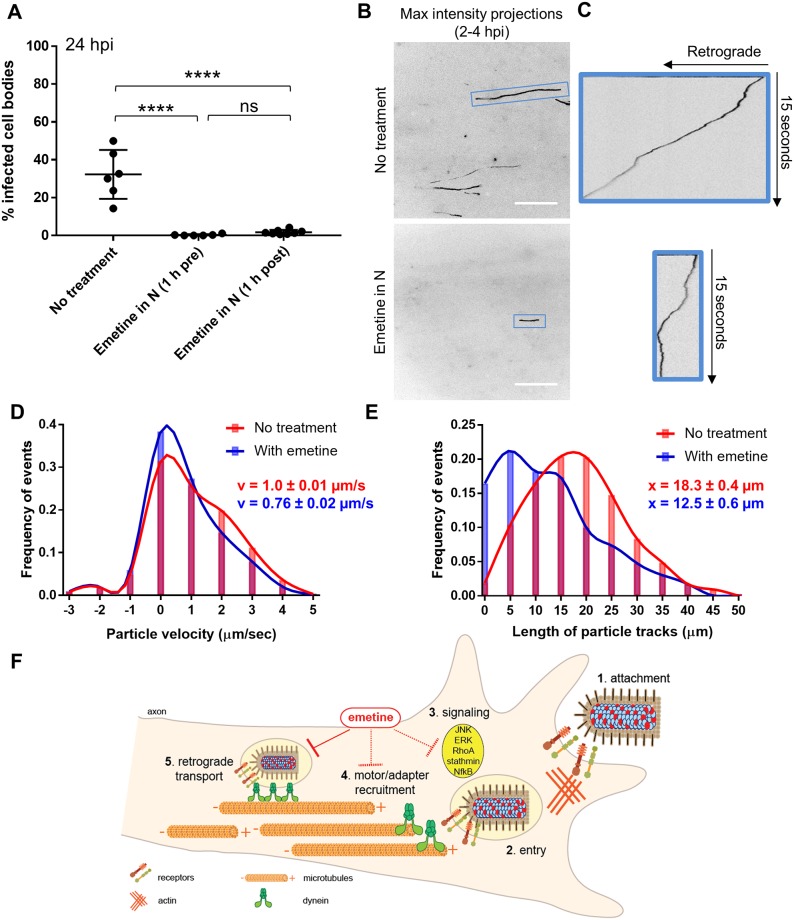
Emetine acts after RABV entry to reduce the velocity and transport distance of virus particles moving retrograde in axons.(A) Quantification of % infected cell bodies at 24 hpi (+/-) 100 μM emetine added to N either 1 h pre or 1 h post infection. Black dots represent individual tri-chambers (from two independent replicates). Horizontal lines and errors bars represent mean ± SD for each condition with ****p < 0.0001 using one-way ANOVA (ns = not significant). (B) Motile RABV particle tracks (black lines) visualized by maximum intensity projections from each FOV along the M compartment barrier at 2–4 hpi in N (scale bars = 20 μm). (C) For tracks in blue boxes, kymographs show the displacement of particles over time during the 15 sec movie (163 frames). The slope indicates the velocity of particle movement, where a vertical line has a slope of zero and indicates particle stalling. (D) Distribution of RABV particle velocity (μm/sec) across a population of retrograde moving RABV particles in the untreated (red; n = 10300 constant velocity segments from 1116 events) or emetine-pretreated (blue; n = 3363 constant velocity segments from 338 events) condition. Events were pooled from three independent replicates. Y axis indicates the frequency for each velocity on the x-axis. Positive and negative values indicate retrograde and anterograde directed motility, respectively. v = the mean velocity ± standard error of the mean (SEM) (E) Distribution of RABV particle track length for particles moving retrograde in the untreated (red; n = 637 particles) or emetine-pretreated (blue; n = 231 particles) conditions. Y axis indicates the frequency for each track length on the x-axis. x = the mean particle track length (± SEM). Lines on the histograms in (D) and (E) are cubic spline curves. (F) Our suggested model summarizing the effect of emetine on post-entry retrograde transport of RABV virions. RABV particles first attach to the cell surface receptors (step 1) to initiate entry through endocytosis (step 2). Step 1 and 2 induce signaling pathways including JNK, ERK, RhoA, stathmin and NfkB in axons (step 3). RABV-carrying endosomes must recruit dynein motors and adapters (step 4) to facilitate efficient retrograde transport on microtubules (step 5). We propose that emetine does not block step 1 or 2, but it interferes with step 5 by possibly inhibiting step 3 and/or 4.